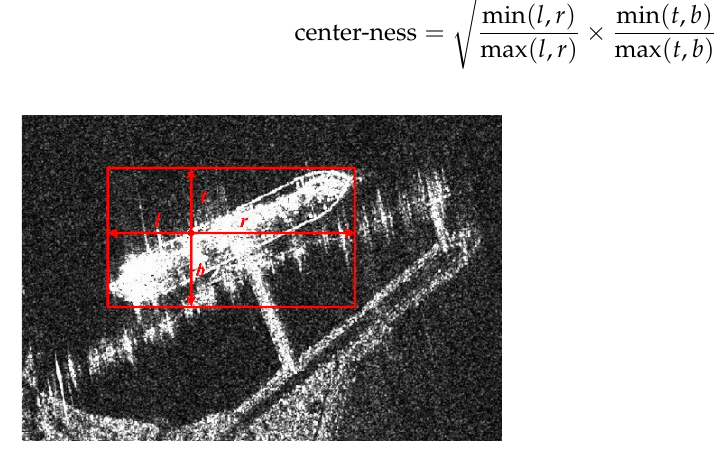
Figure 2. The predicted 4D vector of FCOS.